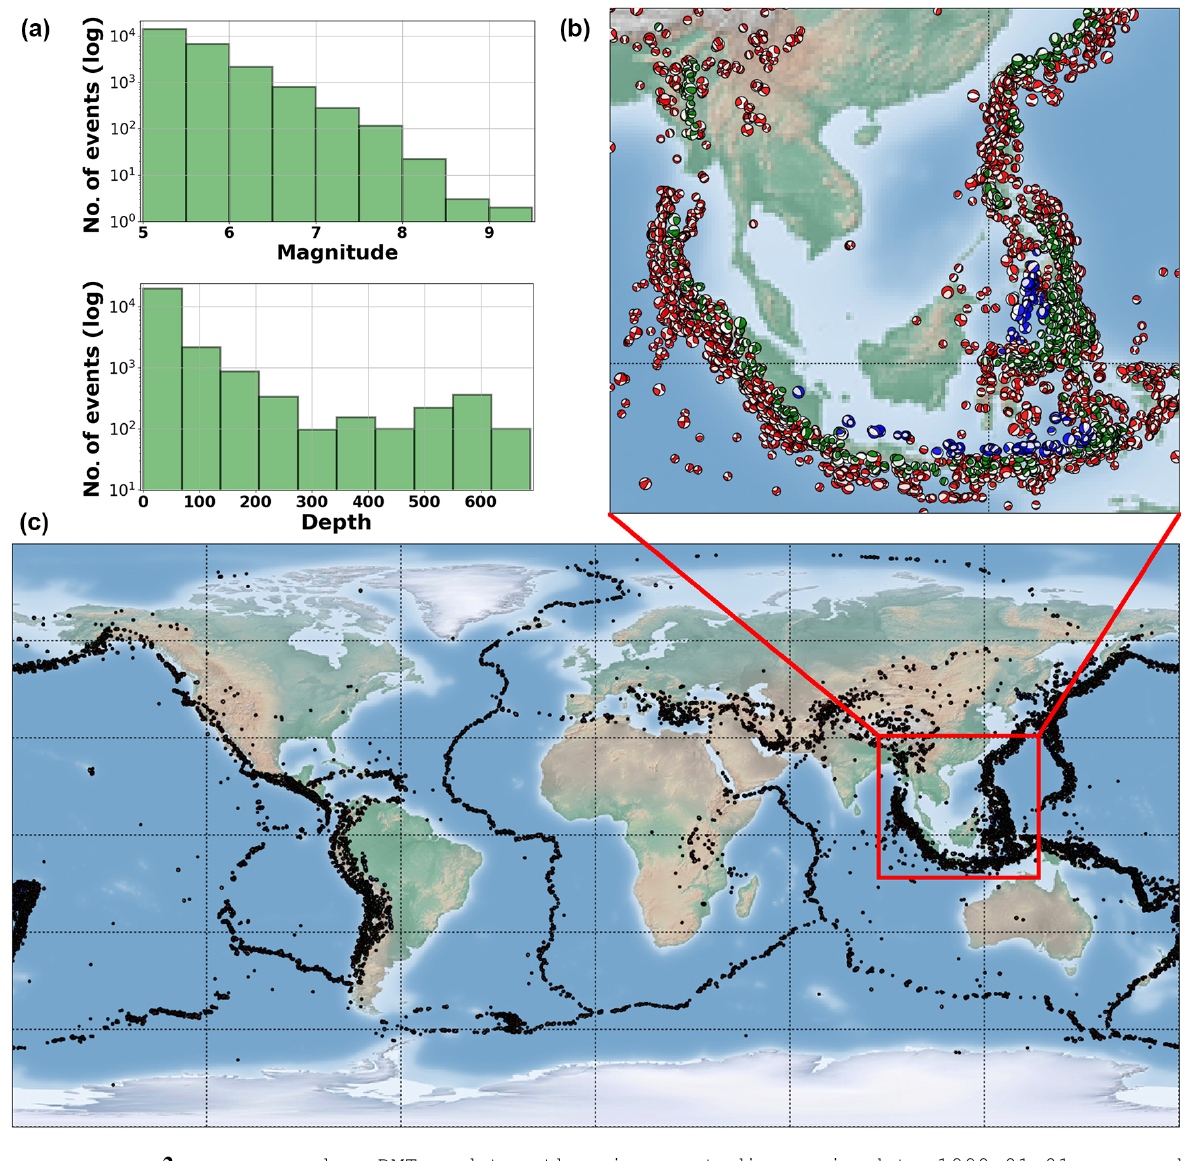
Figure 2. obspyDMT --datapath neic_event_dir --min_date 1990-01-01 --max_date 2017-01-01 --min_mag 5.0 --event_catalog NEIC_USGS --event_info --plot_seismicity Global seismicity map of archived earthquakes in NEIC catalog of a magnitude of more than 5.0 that occurred between 1990 and 2016. One command queried the NEIC catalog, stored and organized the retrieved information and generated the seismicity map. (No actual waveform data were queried in this example.) The results of some basic statistics (magnitude and depth histograms) are also generated and plotted automatically (a) . Note the rendering of colored beach balls in the map inset (deepest seismicity in the foreground). The global map also contains beach balls rather than just simple black dots, but they do not become apparent at this zoom